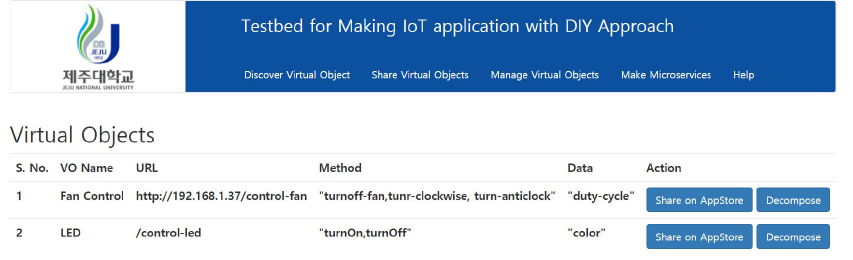
Figure 15. IoT testbed client